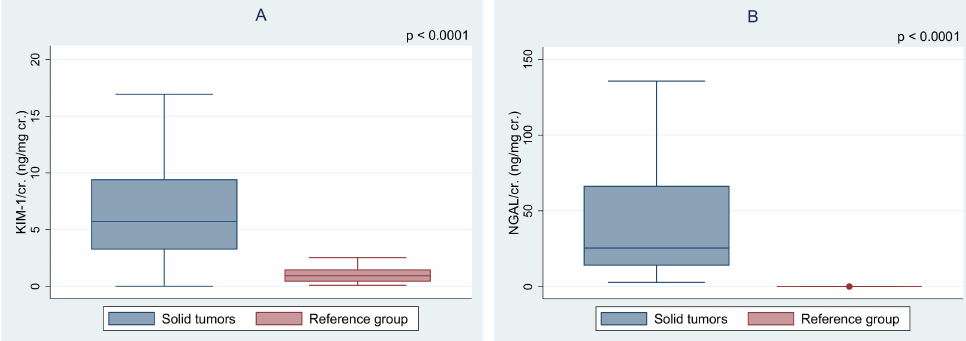
Figure 2. Comparison of ( A ) the urine KIM-1/cr. ratio (kidney injury molecule-1/creatinine) and ( B ) the urine NGAL/cr. ratio (neutrophil gelatinase-associated lipocalin/creatinine) between the solid tumor survivors and the reference group. Table 2. Summary of the biochemical parameters of childhood solid tumors and the reference group. Solid Tumor Me (IQR)